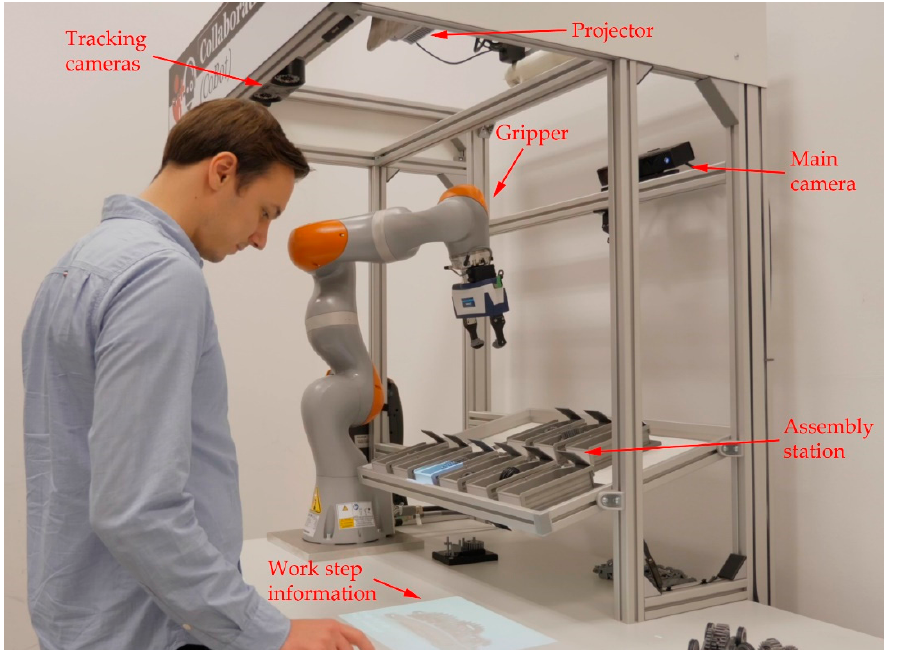
Figure 1. A collaborative manual assembly station.